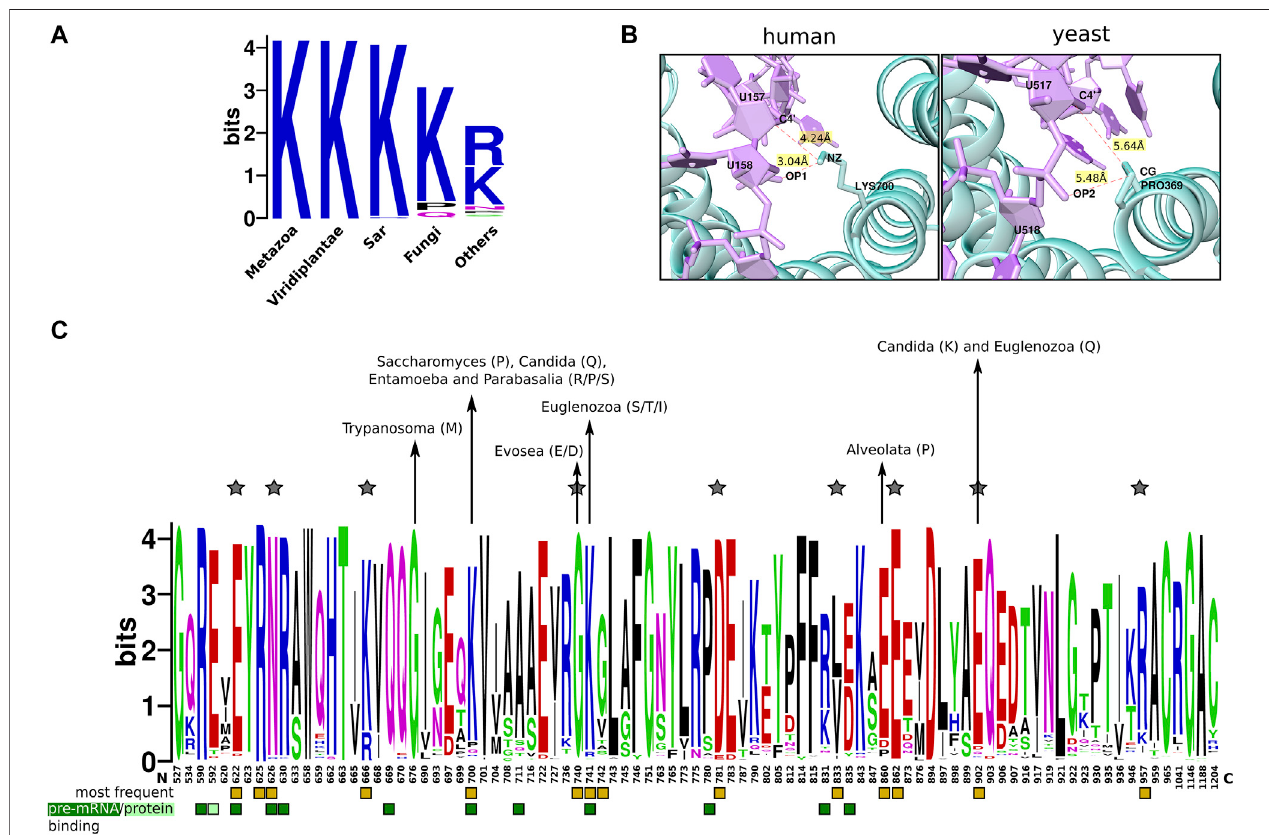
FIGURE 5 | Conservation of cancer-mutation sites in SF3b1. (A) Sequence logo plot shows taxa-speci fi c residue substitution of Lys700 across eukaryotes (reference is human SF3b1). (B) Shown is the cartoon representation of the interaction of Lys700 (or P369 in yeast homolog) with pre-mRNA in human (left) and yeast SF3bcomplex(right),asobservedinthecryo-EMstructurescorrespondingtoPDBcodes5Z58and5GM6,respectively(Yanetal.,2016;Zhangetal.,2018). (C) Shown isasequencelogorepresentingresiduesubstitutionpatternsof89cancermutationsites(Crooksetal.,2004).Substitutionpatternsofresidueswereobtainedfrom 1756homologsofSF3b1.Interfaceresiduesforprotein-proteininteractions(lightgreen)andprotein-RNAinteractions(darkgreen)arehighlightedbysquareboxesatthe bottom. Yellow boxesmark hotspot positions thatfrequently get mutated incancers.Taxa-speci fi csubstitutions are highlighted witharrows. Positions inwhich thetype of substitution is natural in other eukaryotes but causes cancers in humans are indicated by the star